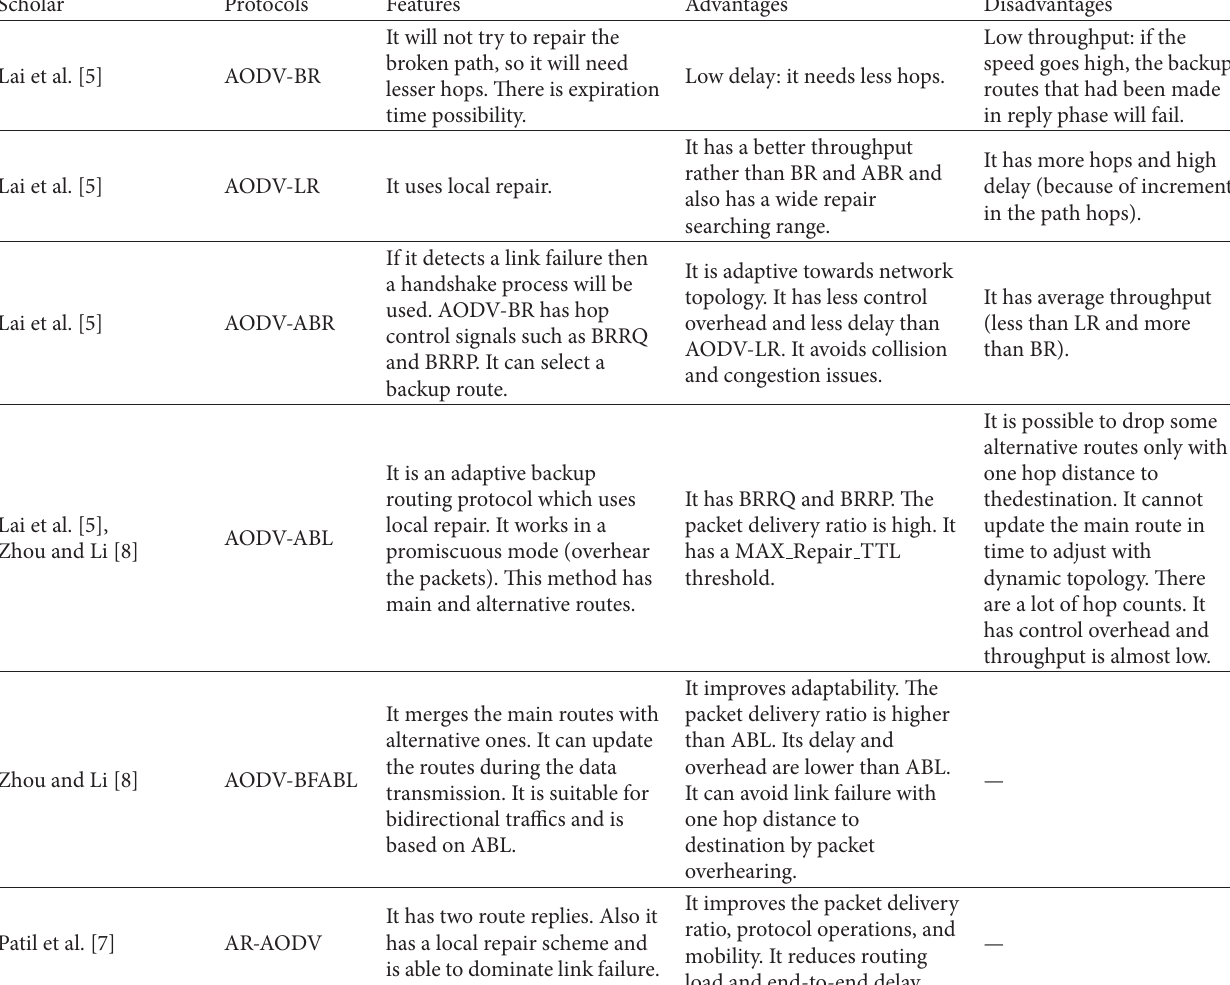
Table 1: Comparison of discussed